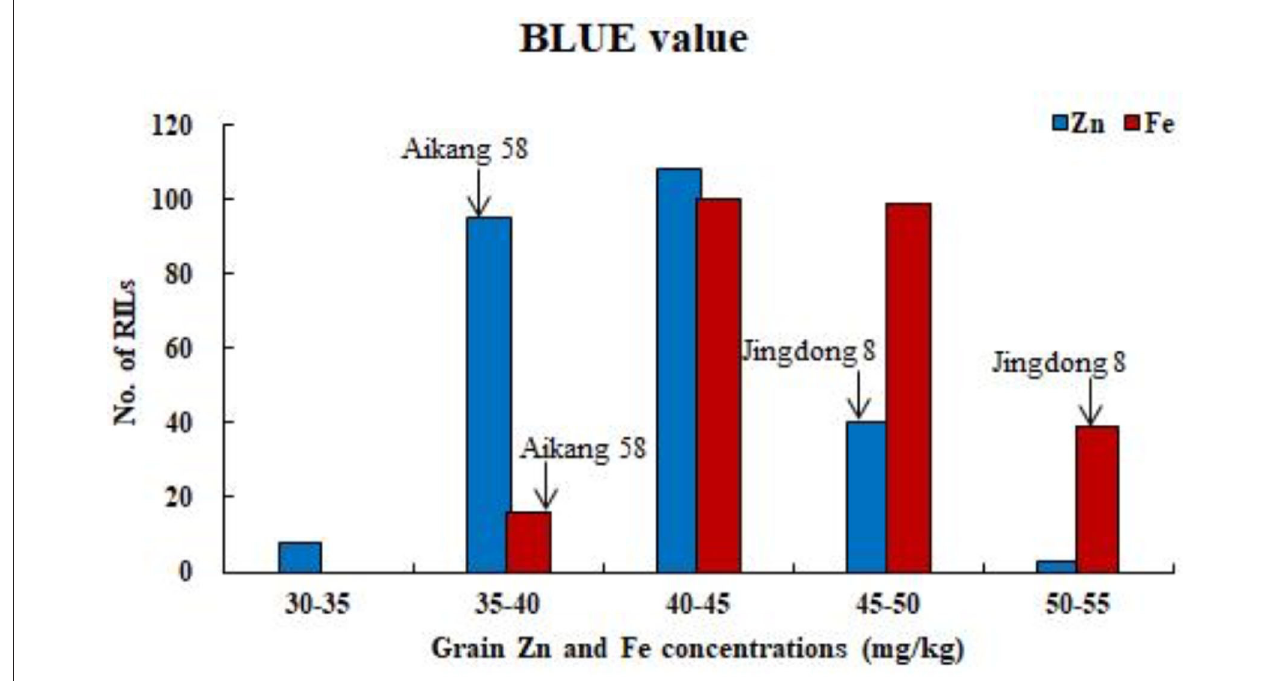
FIGURE 1 | Frequency distributions of GZn and GFe based on BLUE value across nine environments for 254 RILs in the Jingdong 8/Bainong AK58 population.